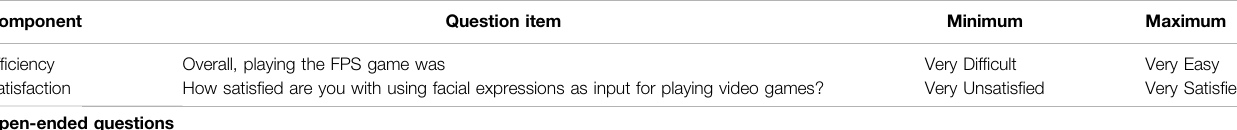
TABLE 3 | The fi rst part of the post-study questionnaire. The fi rst two questions were rated on a seven-point Likert scale and the second two questions are open-ended questions. Component